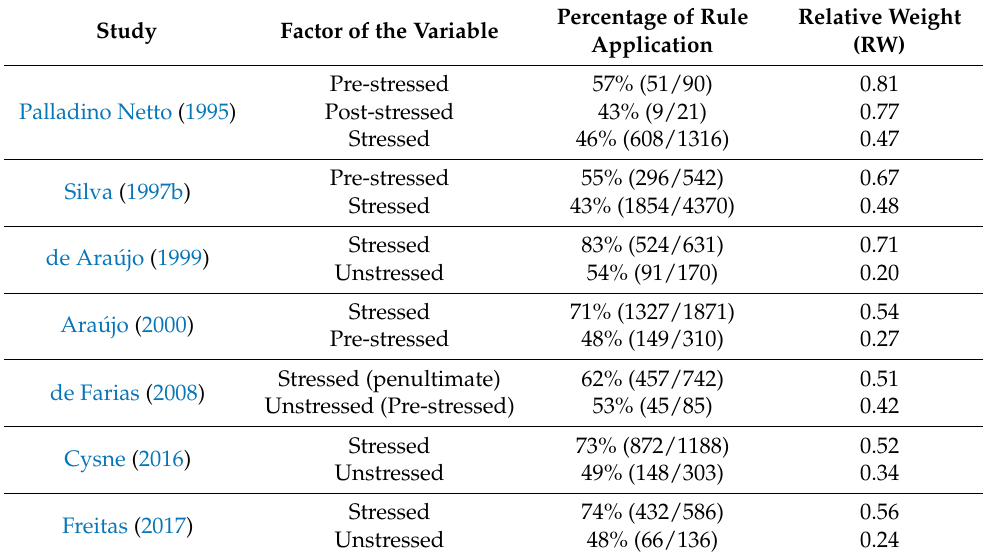
Table 5. Effects of the factors of the variable tonicity .